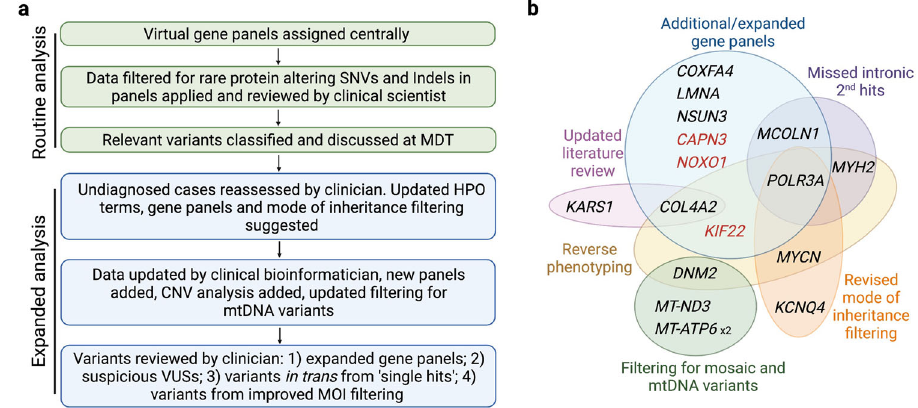
Fig. 1 | Methodology for data analysis and themes identi fi ed in additional diagnoses. a Methodology adopted in study. Green panels=routine analysis in 100,000 Genomes Project clinical arm with interpretation undertaken by clinical